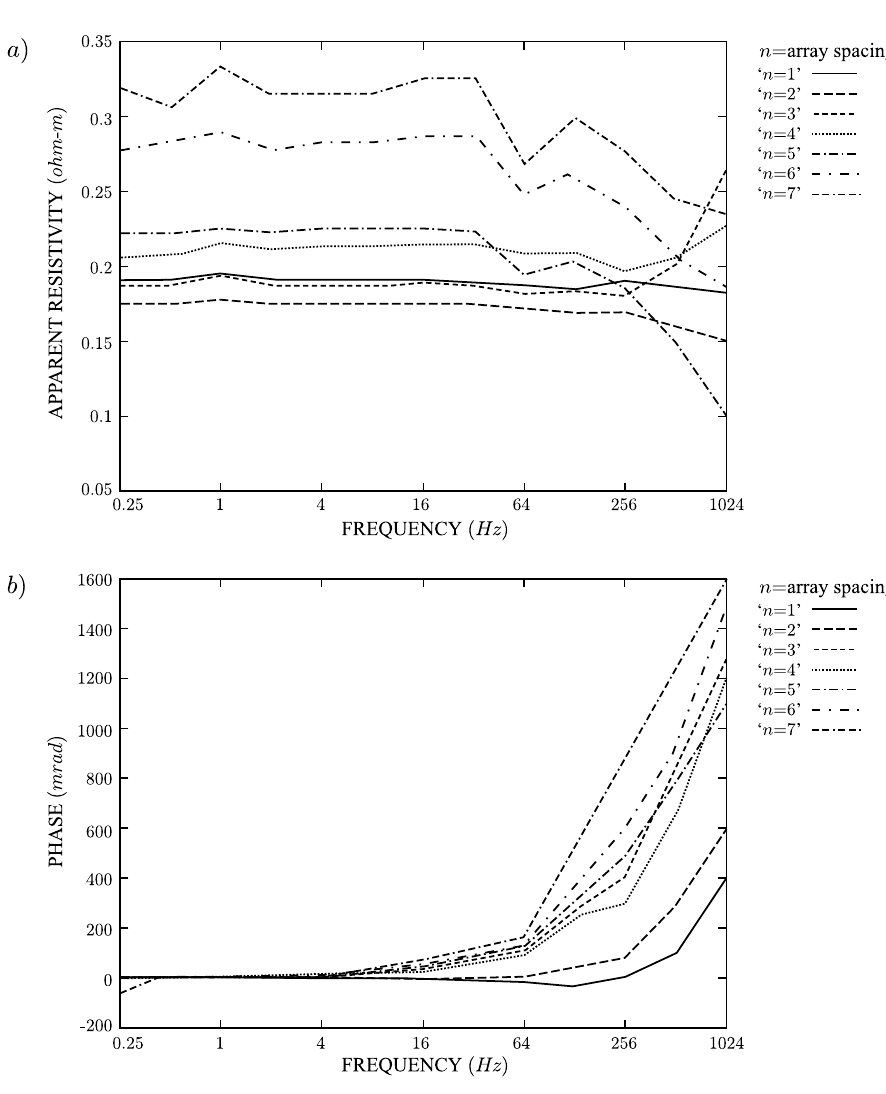
Fig. 6 – Behavior of (a) the amplitude and (b) the phase of the apparent resistivity 7 m deep, for the seven array spacing of investigation, and for the bar electrode (0.10